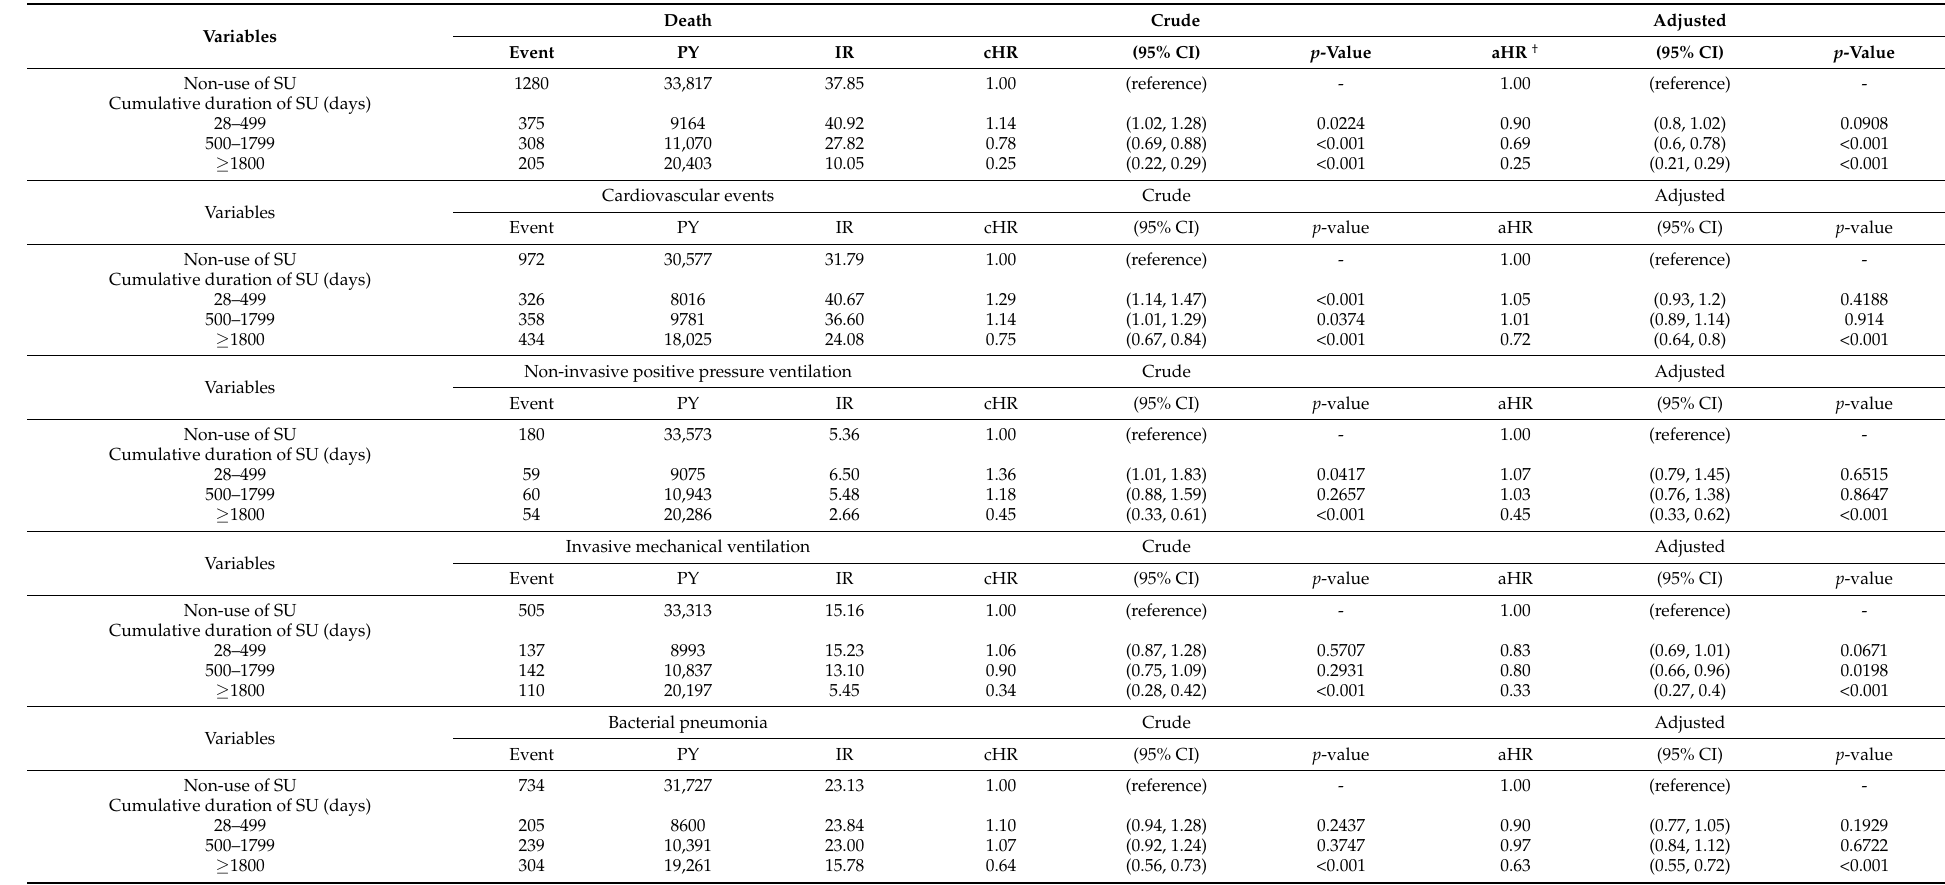
Table 3. The risk of different outcomes in patients with or without sulfonylurea